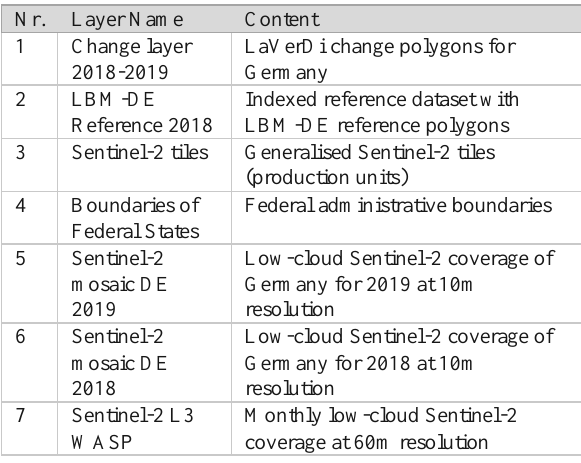
Table 8 . Description of the layers integrated in the service For each change polygon, the probability of change in the categories not relevant, very low, low, medium and high is indicated in the upper part of the window next to the area statistics. This is followed by the direction of change (e.g. from crop land in T0 to built-up area in T1) with the NDVI metrics. The latter are always given, but are only relevant for one feature due to the class-specific analysis. As described in section 3.1, the NDVI metrics given are: NDVI mean, NDVI 90% percentile, NDVI 10% percentile and NDVI percentile difference from the 90%/10% percentiles. The metrics are normalised among themselves and therefore only comparable between years, but not within a